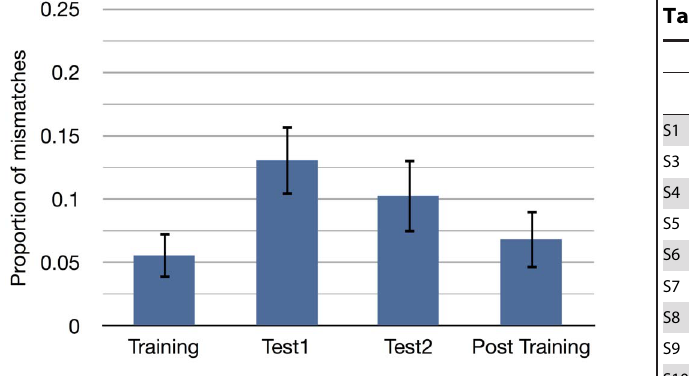
Figure 6. Mismatch. Mismatch between codebook based on Leuven association dataset and button presses. Only the unique mismatches were counted. Error bars are corrected for a within subject design [31], p. 361–366.